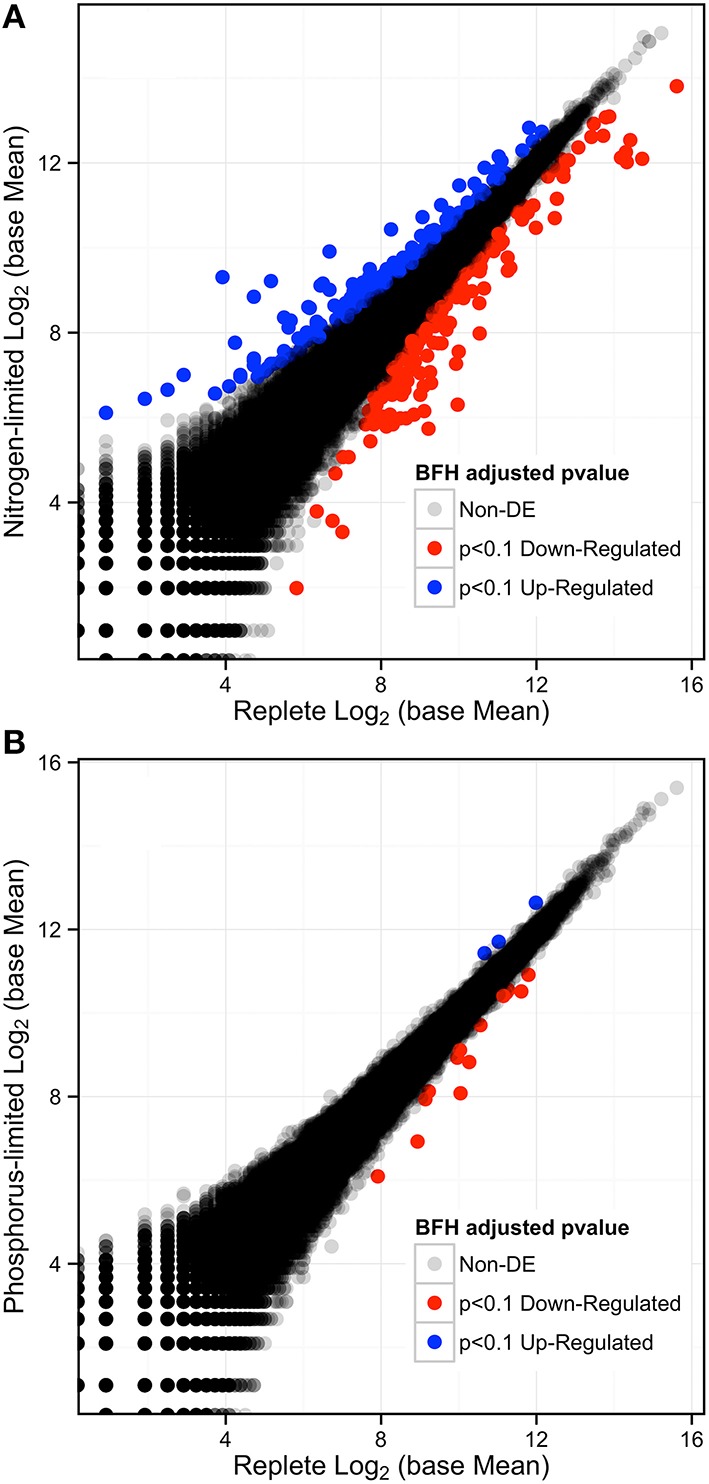
(A) Log-Log plot of expression levels comparing the replete to the N-depletion treatment showing the number of differentially expressed genes in red (down-regulated) and blue (up-regulated), and those that are no DE are in gray-black with p-adjusted to an FDR < 0.1. (B) Log-Log Plot of expression levels comparing the replete to the P-limited treatment.